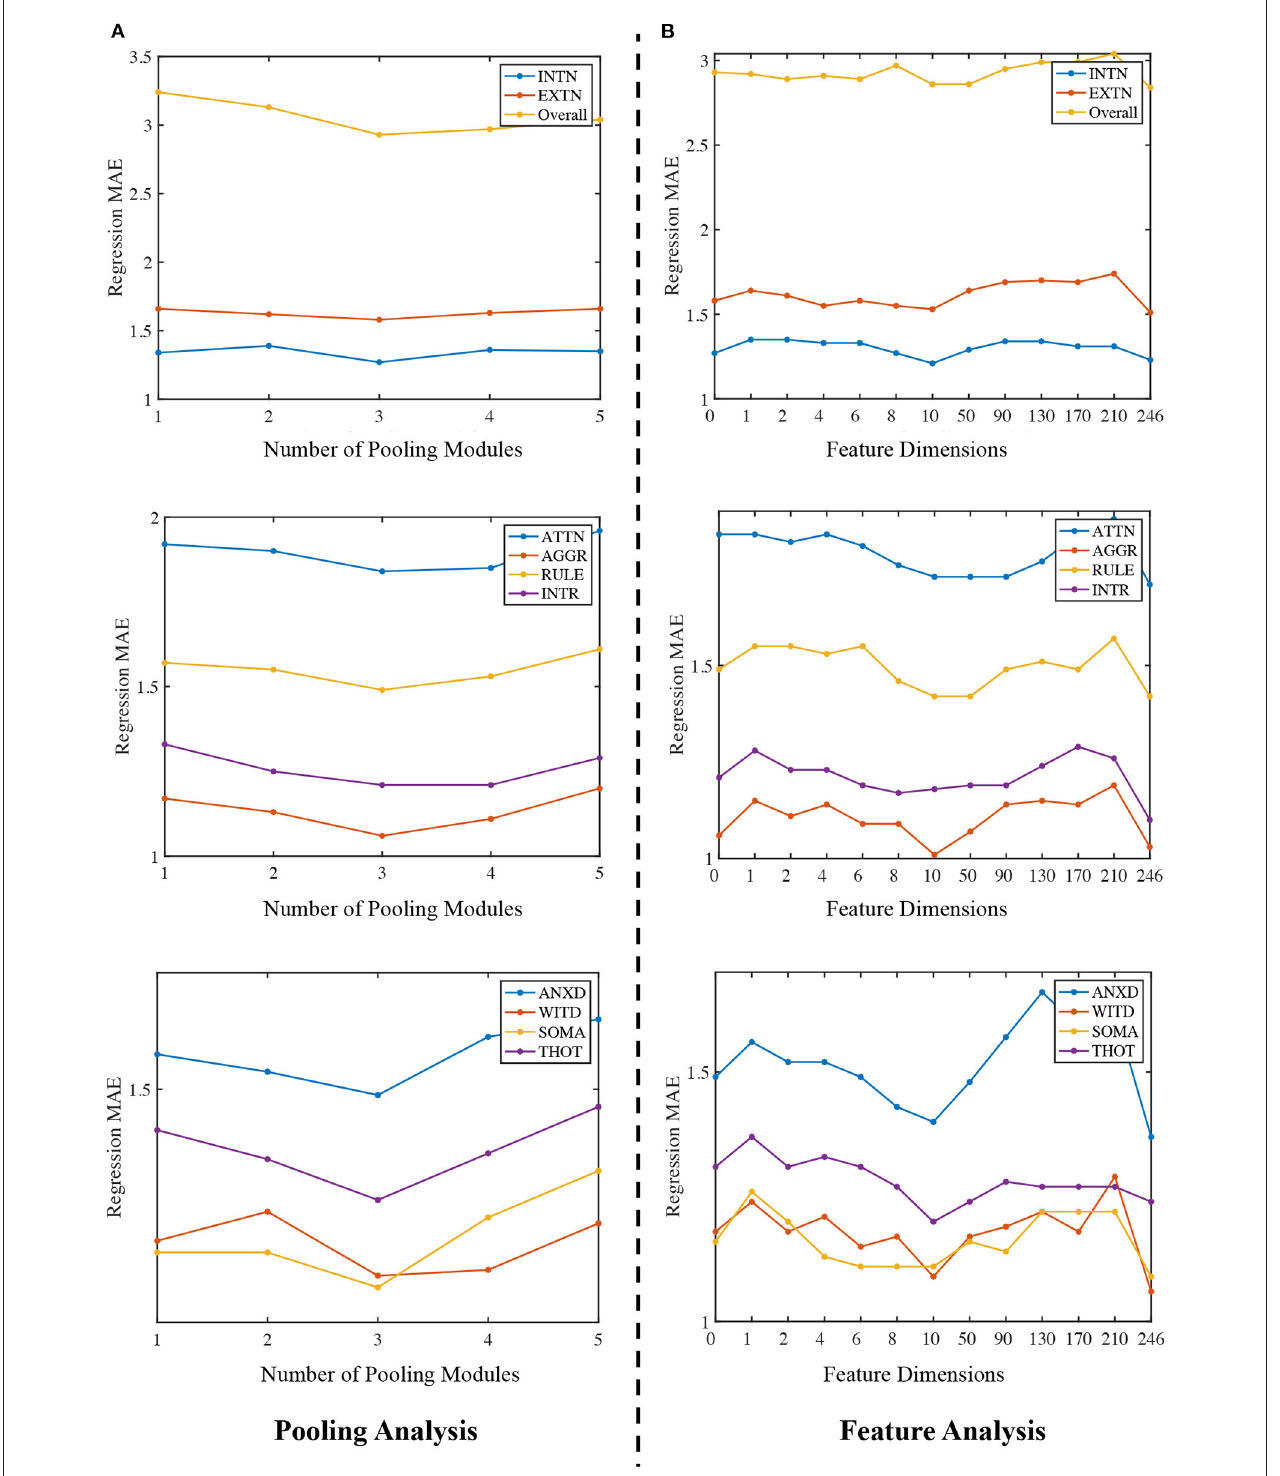
FIGURE 3 | Ablation study. (A) Regression MAE under different number of pooling modules. The x-axis is 1 to 5, representing the number of community pooling modules and y-axis is the corresponding MAE. (B) Regression MAE obtained by the proposed framework when using different number of node features. The x-axis ranges from 0 to 246, representing different number of nodal features and y-axis is the corresponding MAE.